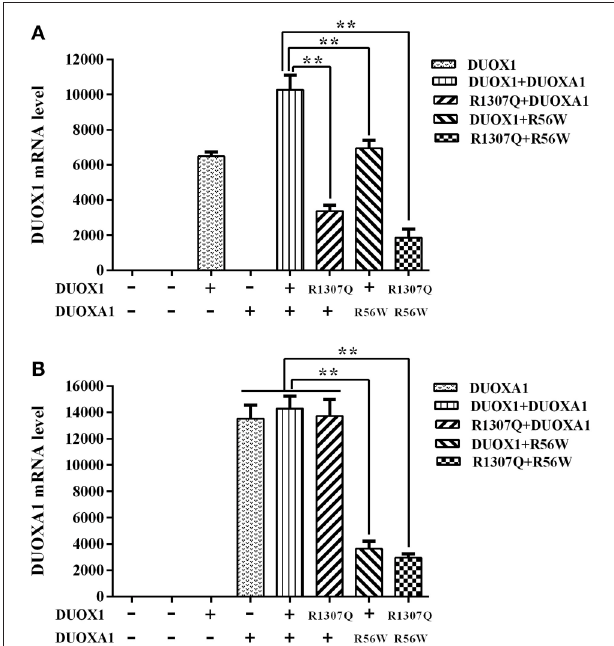
FIGURE 3 | Relative mRNA expression levels under the various indicated vector transfections. (A) DUOX1 mRNA expression. The DUOX1 mRNA level was highest in the group with both wild-type DUOX1 and DUOXA1 expression vectors, while the group with p.R1307Q and p.R56W combination had the least mRNA expression of the DUOX1 gene compared with other experimental groups except for the group with DUOXA1 only. (B) DUOXA1 mRNA expression. Groups with p.R56W mutant were far lower than other experimental groups with DUOXA1 . Each column represents the mean ± SD of three independent experiments performed in triplicate. ** P <